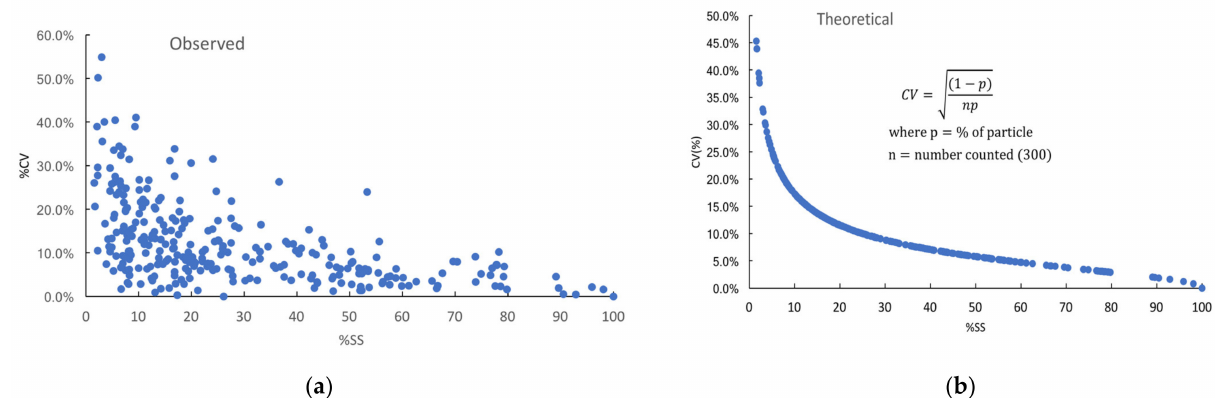
Figure 8. Stamp sand grain counts (% stamp sand) generally follow a binomial distribution. When plotted against % SS, observed CVs from grain counts ( a ) and predicted CVs from the Binomial Distribution ( b ) closely correspond. The Binomial formula for expected CV’s is inserted in the right